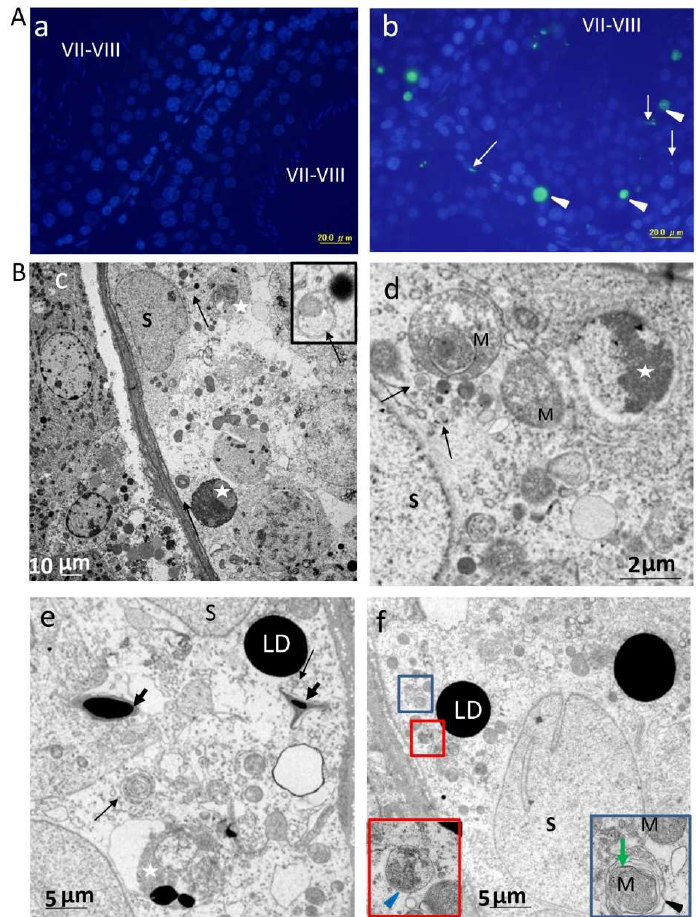
Figure 6. Accumulation of apoptotic germ cells, retained sperm, damaged mitochondria and large LDs in SCs of ETRs at stages VII-VIII. ( A ) TUNEL labeling of apoptotic cells (white arrow heads) in control (a) and ETR (b) testes. The white arrows mark retained sperm with TUNEL positivity apparently phagocytosed by SCs. ( B ) TEM showing apoptotic germ cells (stars in c–e) and retained sperm (short arrows in e) phagocytosed by SCs of ETRs. The insets in f are higher magnifications of the boxed areas, demonstrating a mitophagosome marked by green arrow (right inset) and autolysosome marked by blue arrow head (left inset). The long black arrows indicate AVs, while the black arrow head in the right inset marks autophagosomal membrane. M: damaged mitochondria; S: SC nucleus; LD: lipid